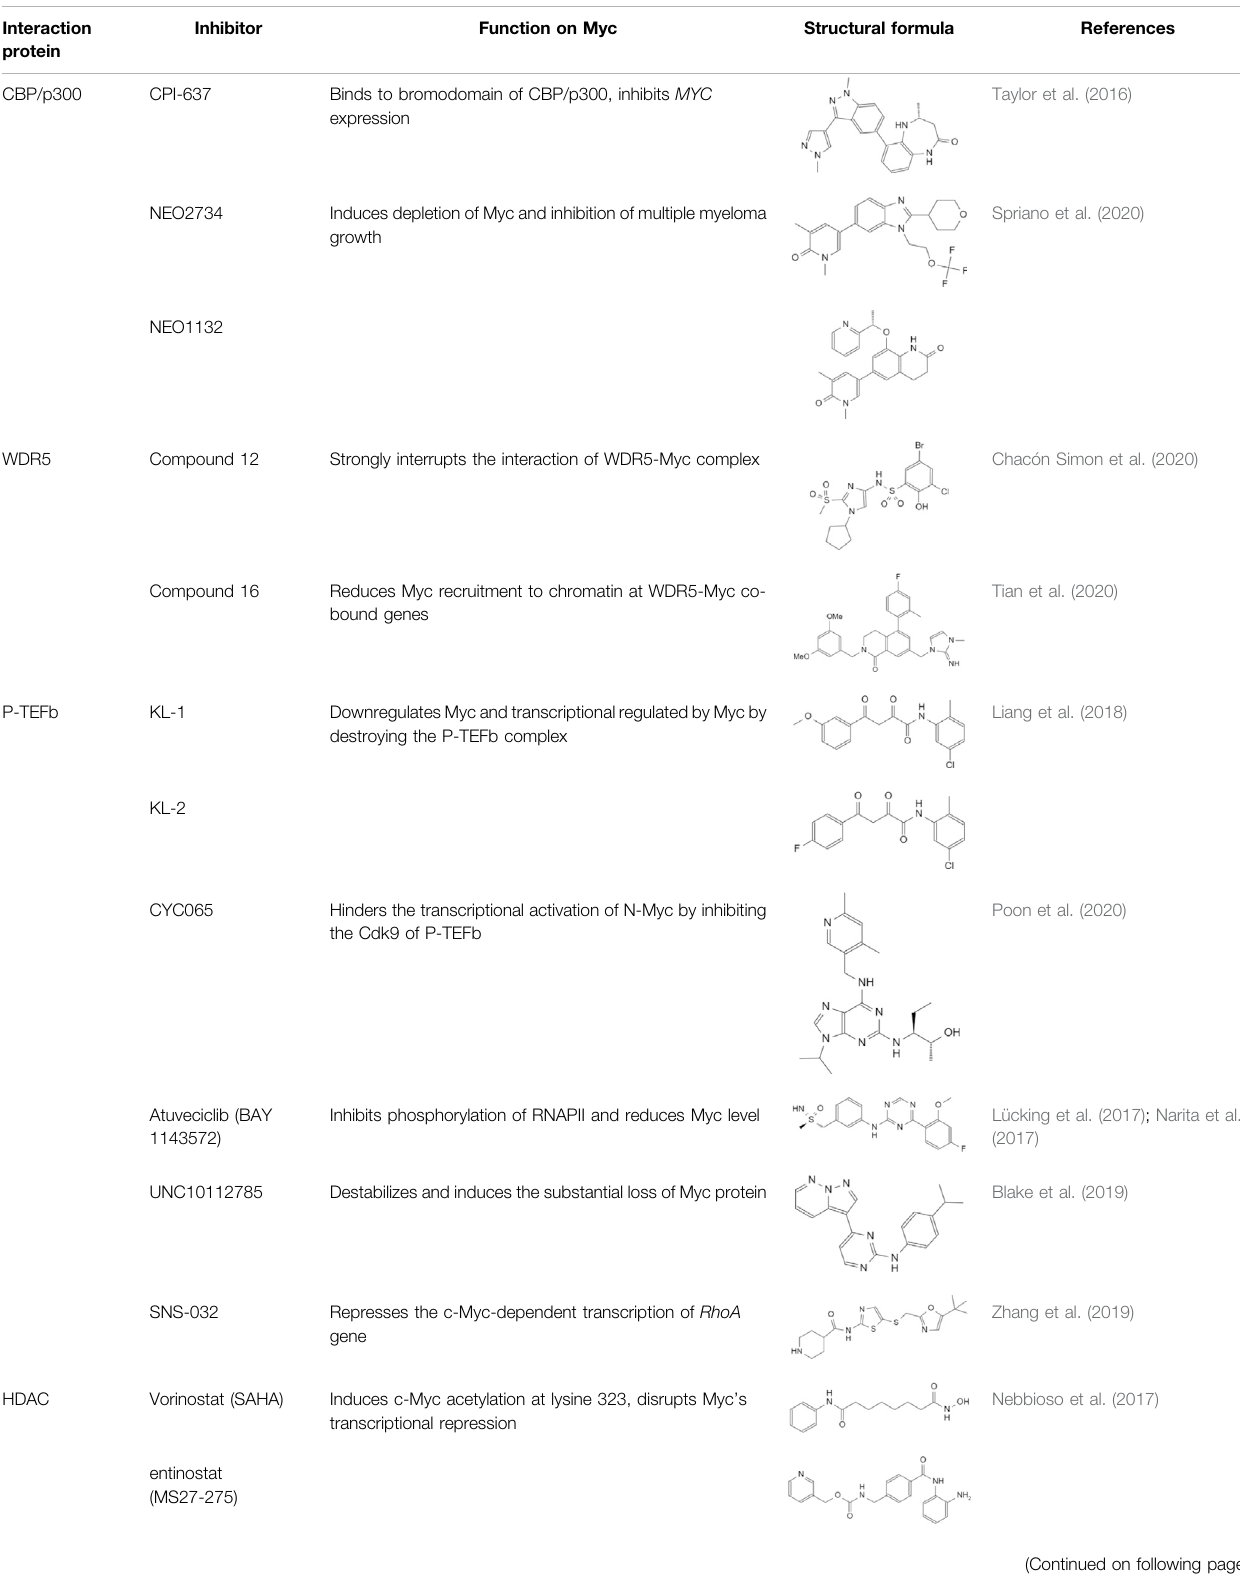
TABLE 1 | Inhibitors and functions of Myc interaction